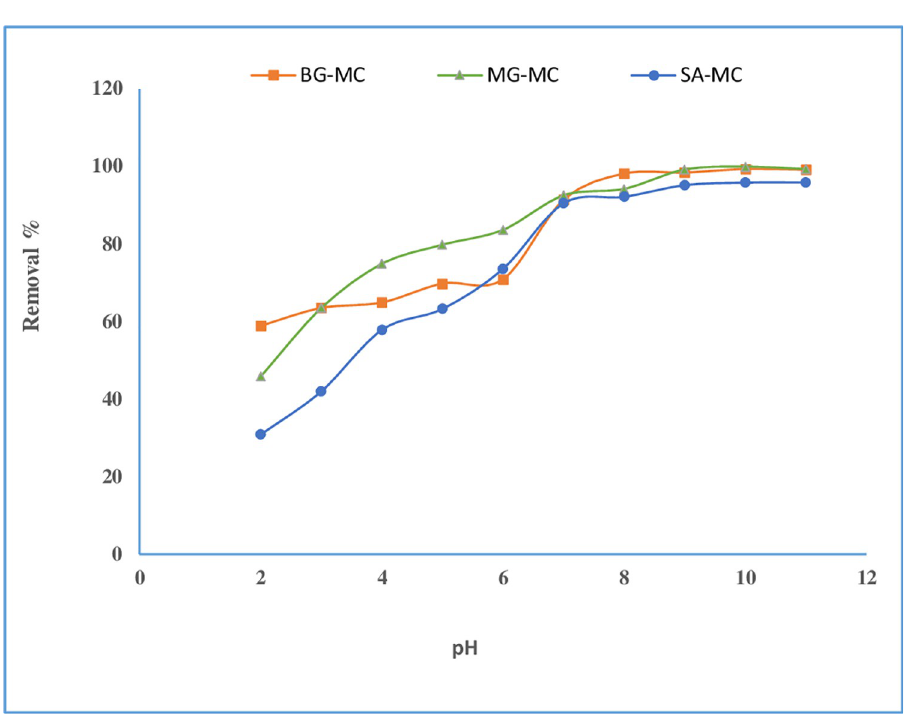
Fig 6. Effect of pH on removal percentage of BG, MG, and SA onto